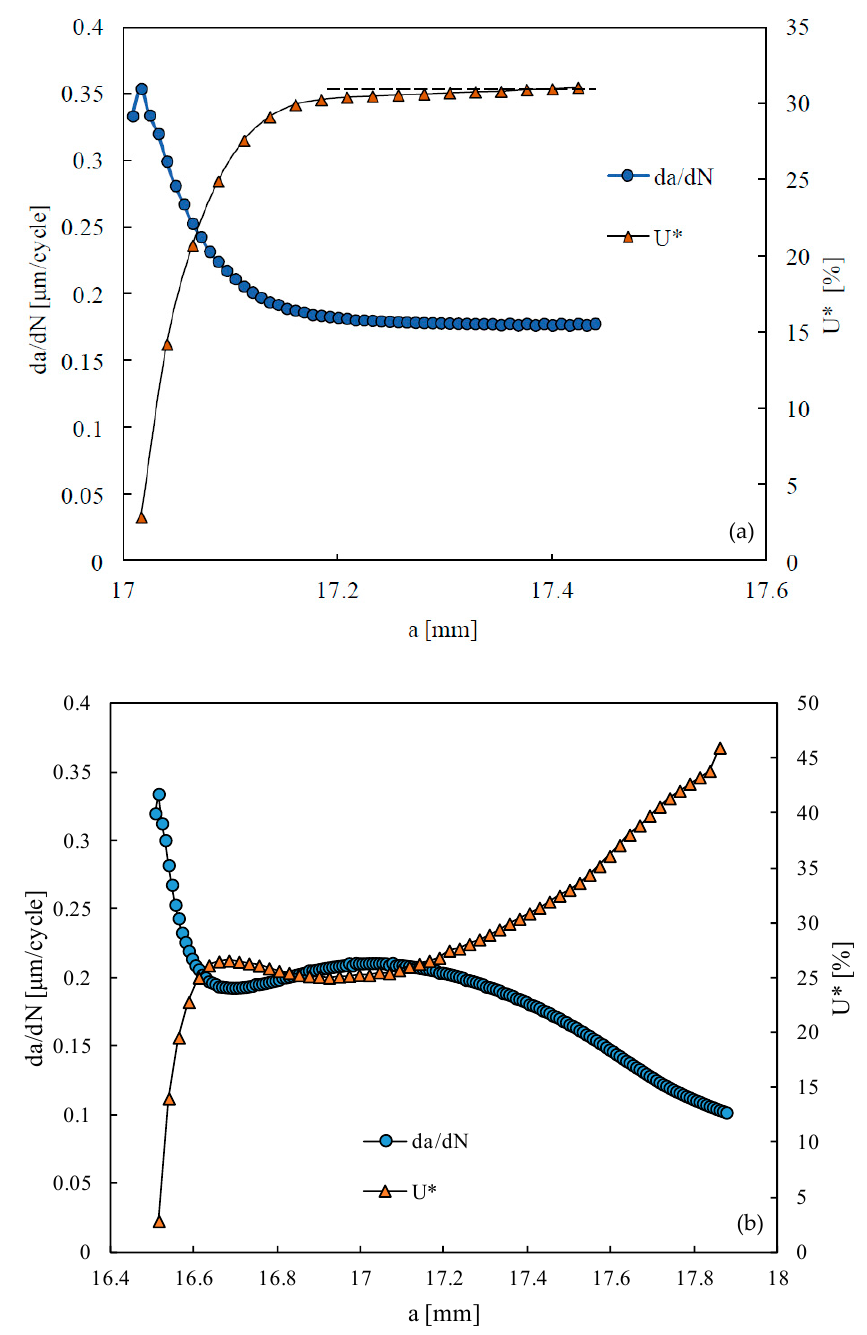
Figure 7. Crack closure level versus crack length in case A. ( a ) Without TRS. ( b ) With TRS.